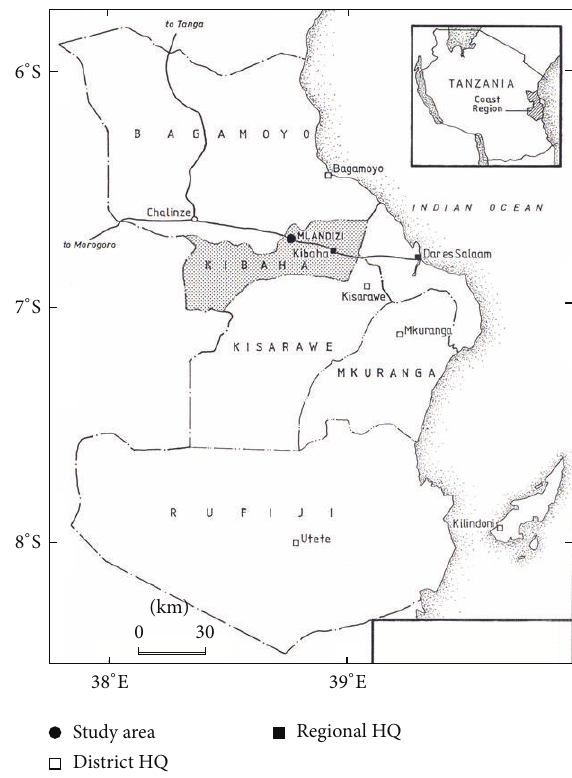
Figure 1: Location of the study